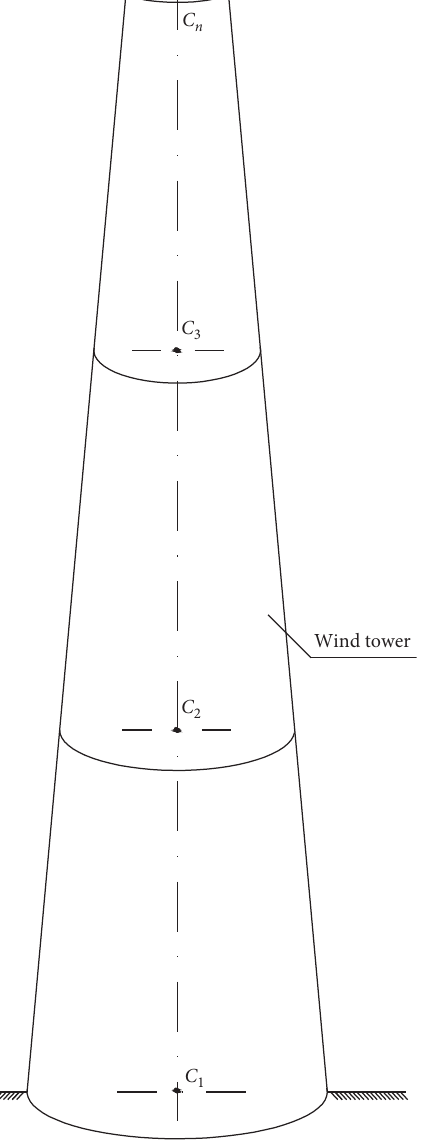
Figure 1: The schematic of wind